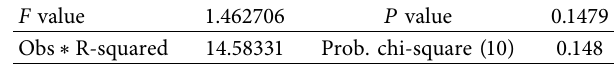
Table 5: ARCH-LM test of GARCH (1,